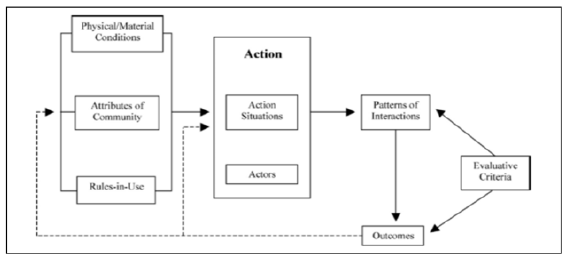
Figure 6. Framework for Institutional Analysis and Development (Ostrom, 2005; 2010).